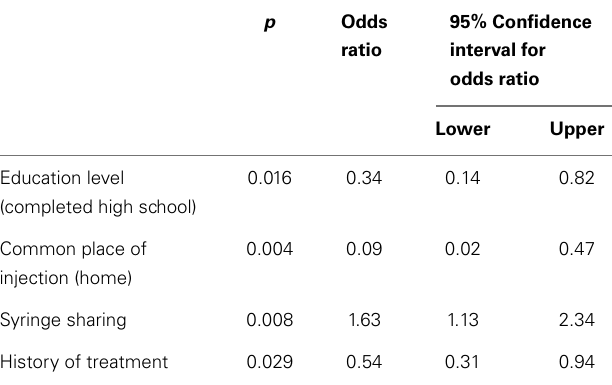
Table 3 |Associated factors of inconsistent condom use based on a logistic regression